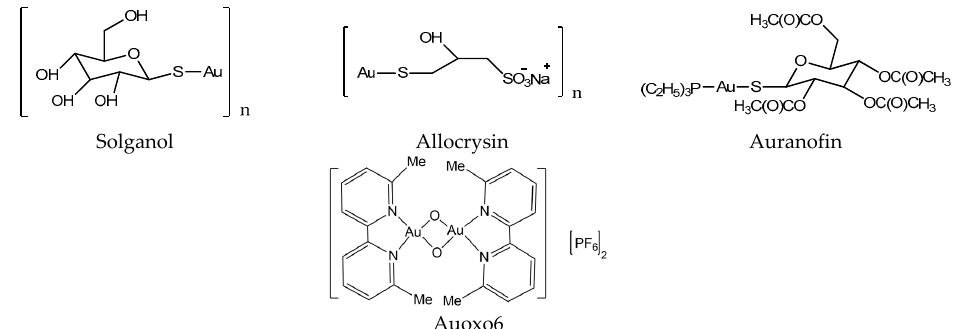
Figure 4. Chemical structure of gold anticancer drugs.